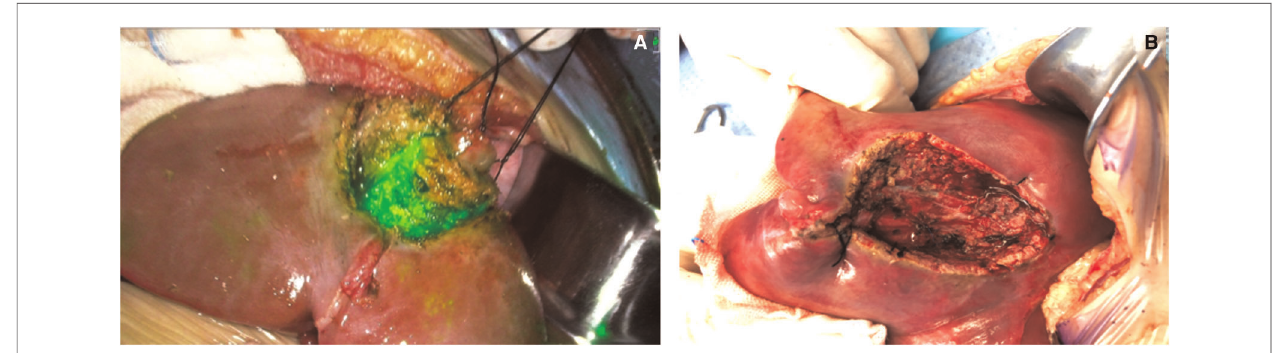
FIGURE 1 | Real-time modi fi ed resection plane by indocyanine green (ICG) fl uorescence imaging ( A ) and after complete resection ( B